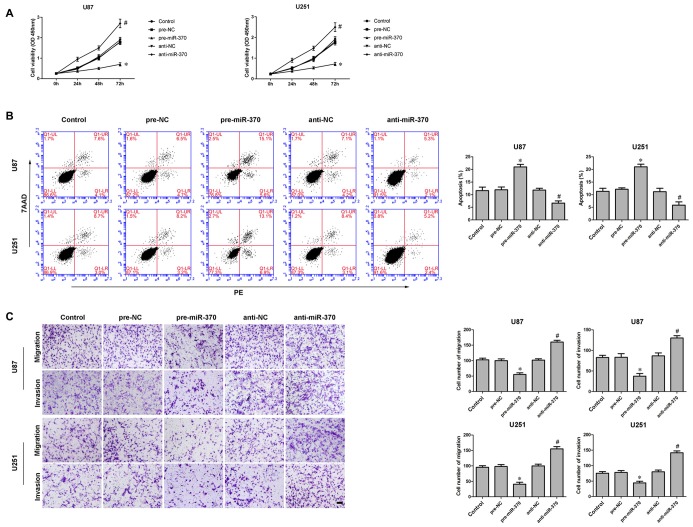
Effect of miR-370 on proliferation, migration, invasion and apoptosis of human glioma cells. (A) Cell counting Kit-8 (CCK-8) assay was used to determine the proliferation effect of miR-370 on human glioma cells at 24 h, 48 h and 72 h. (B) Flow cytometry analysis of human glioma cells with the expression of miR-370 changed. (C) Quantification of migration and invasion cells with the expression of miR-370 changed. Representative images and accompanying statistical plots were presented. Data are presented as the mean ± SD (n = 5, each group). *P < 0.05 vs. pre-NC group; #P < 0.05 vs. anti-NC group. Scale bars represent 20 μm.